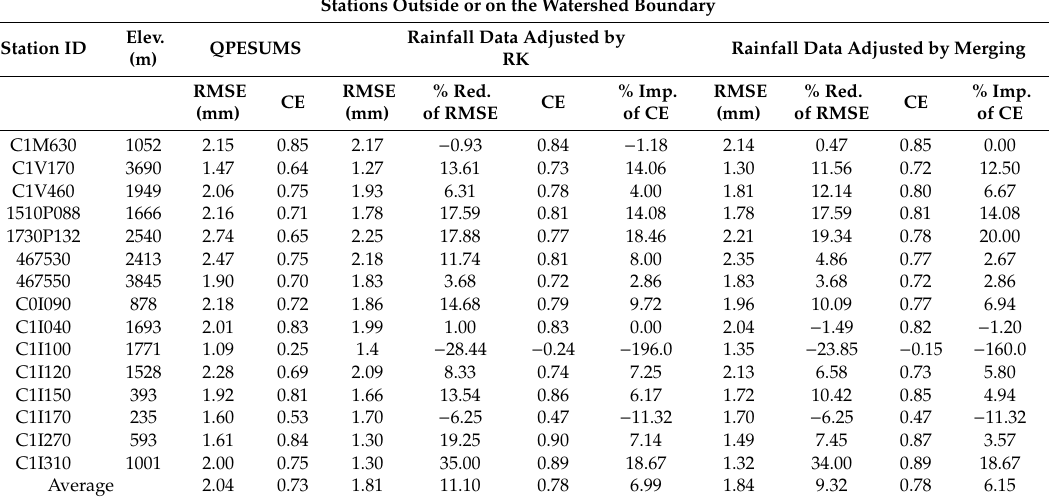
Table 2. RMSE and CE for the unadjusted QPESUMS data and adjusted radar rainfall values using RK and merging for stations outside or on the watershed boundary during the event of Typhoon Kalmaegi. The values of percentage reduction (% Red.) in the RMSE, percentage improvement (% Imp.) in CE, and station elevation (Elev.) are also included. The values at station C1I100 were not used in the calculation of the averaged